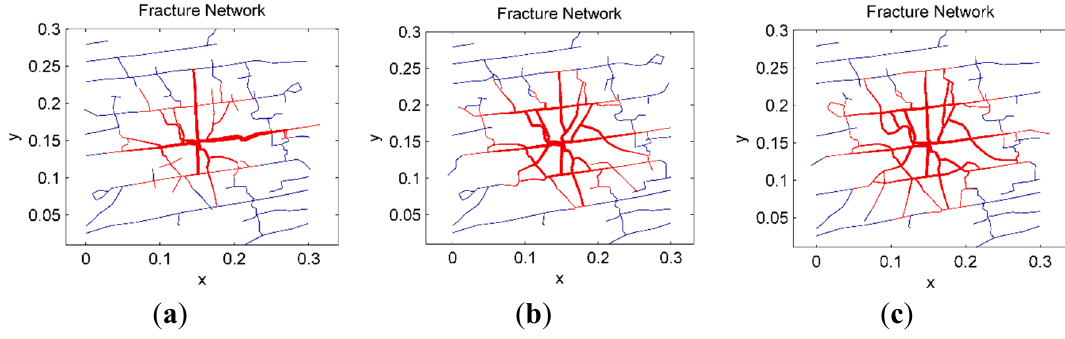
Figure 11. Fracture network configurations under same values of M and SA . The fractures affected by the fluid injection are colored red and other fractures are colored blue: ( a ) σ (cid:3398) σ (cid:3404) 1 MPa, μ (cid:3404) 1 cP, (cid:1837) (cid:3404) 0.5 MPa. m (cid:2868).(cid:2873) ( b ) σ (cid:3051) (cid:3052) (cid:2893)(cid:2887) μ (cid:3404) 81 cP, K (cid:3404) 1.5 MPa. m (cid:2868).(cid:2873) ; ( c ) σ (cid:3398) σ (cid:3404) 5 MPa, μ (cid:3404) 625 cP, (cid:1837) (cid:2893)(cid:2887) (cid:3051) (cid:3052) Table 5. Input